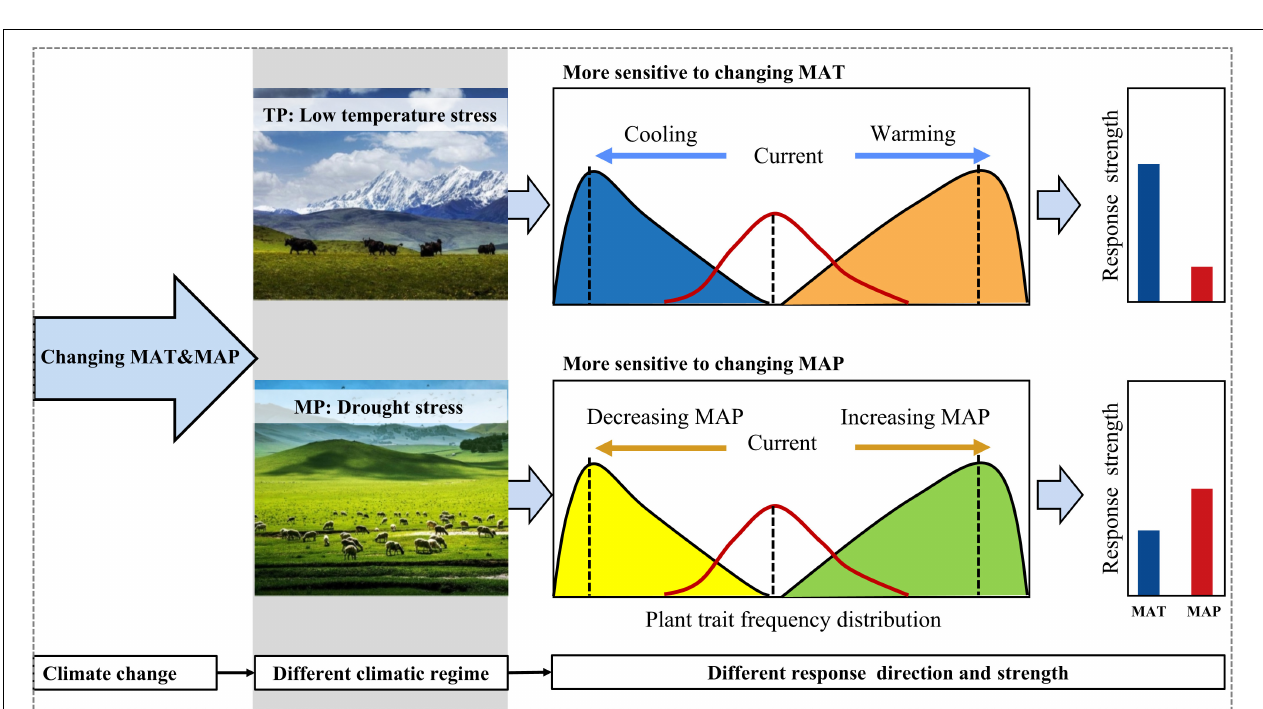
FIGURE 5 | The relative prevalence of convergence and divergence within grassland communities among different regions, which were evaluated based on standardized effect values (SES) for the variance in height, SLA and, and leaf dry matter content (LDMC) distributions within grassland communities (SES.Var.H, SES.Var.SLA, and SES.Var.LDMC). The red dashed line indicates the 50% quantile. Convergence: SES < 0; divergence: SES > 0. SES. Var.H, SES.Var.SLA, and SES.Var.LDMC represent the standardized effect size values of community-weighted variance of height, SLA, and LDMC, respectively.